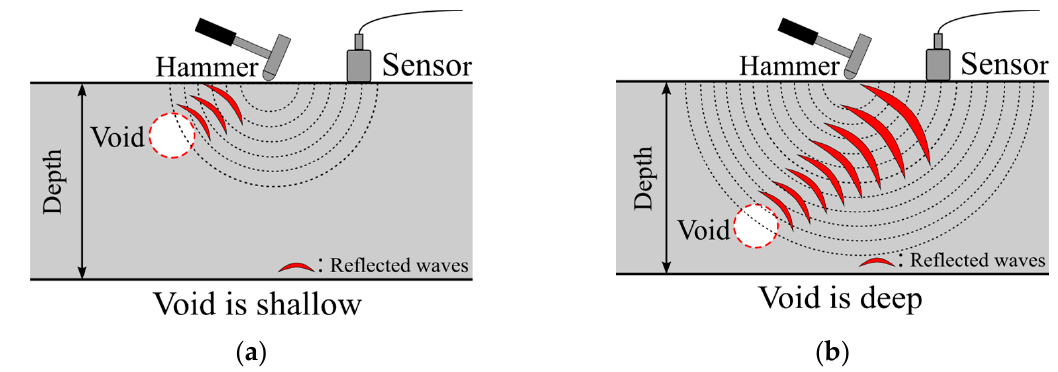
Figure 17. DVA results (X-axis of point = 800 mm): ( a ) Comparison by depth; ( b ) Comparison by sheath diameter.